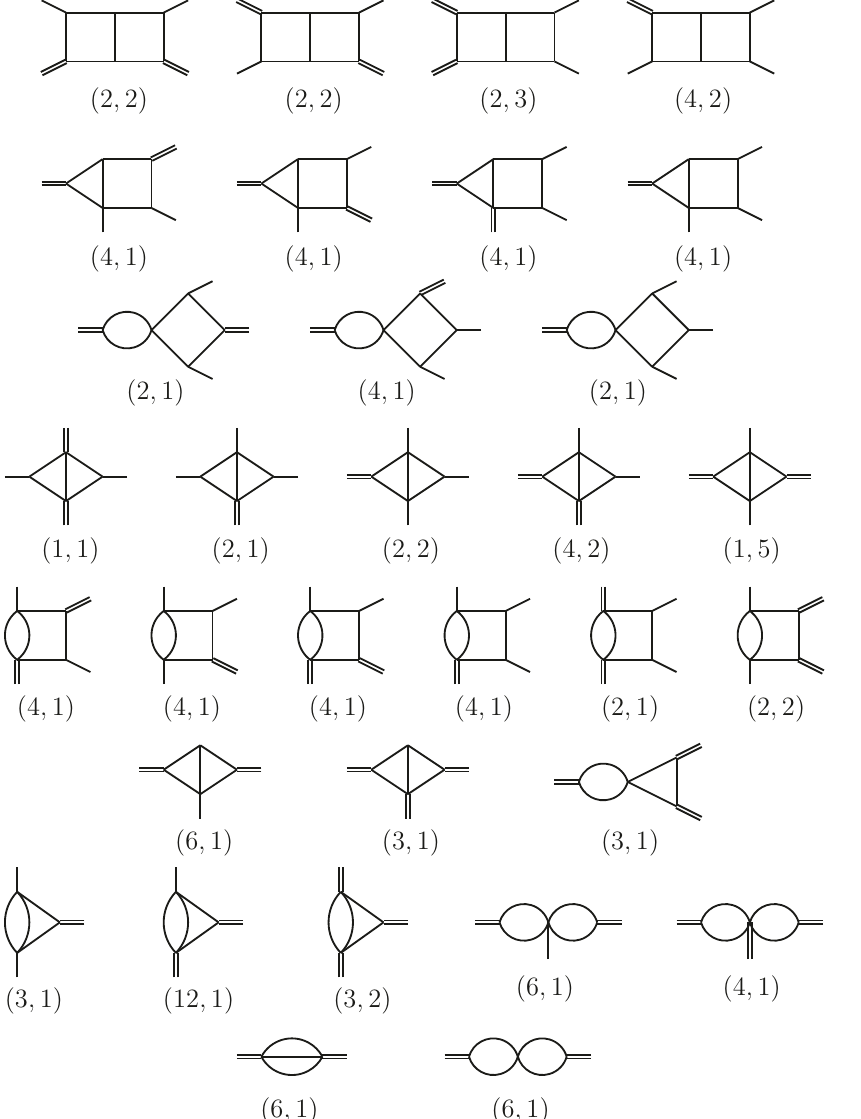
Figure 3 . Master integrals for leading colour W + 4 parton scattering at two loops with four external legs or fewer. ( a; b ) represents the number of crossing of external legs ( a ) and the number master integral for a given topology ( b ). A massless (massive) external leg is indicated by a single (double) line external leg. All master integral topologies shown are known analytically.